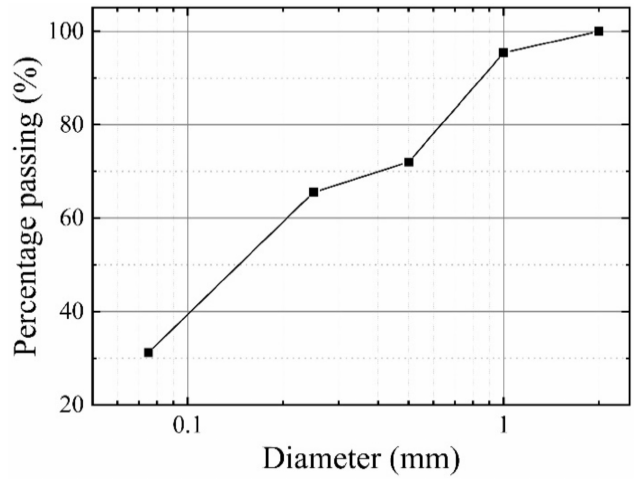
Figure 1. Size distribution of carbonaceous mudstone (CM) particles.